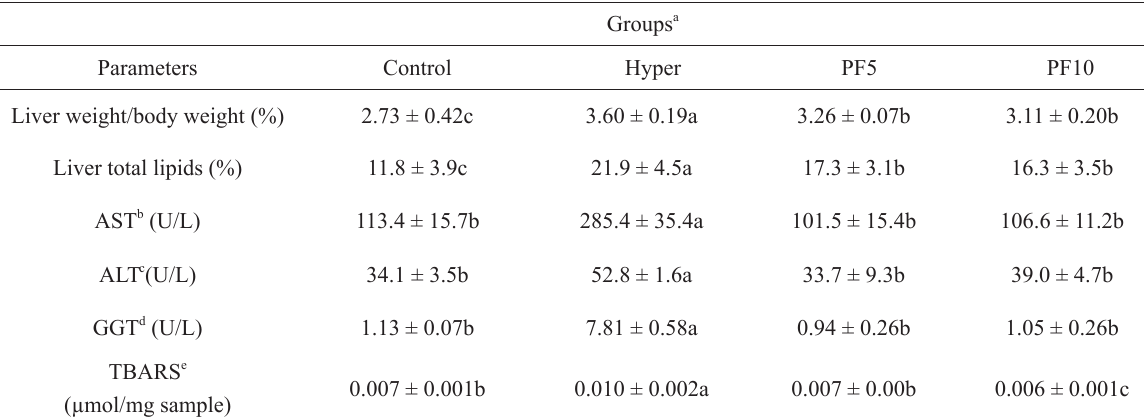
a Data represent the mean ± standard deviation (n = 5). Means followed by the same lowercase letter in the rows do not differ by the Scott-Knott test at 5% probability. b AST, Aspartate aminotransferase. c LT, Alanine